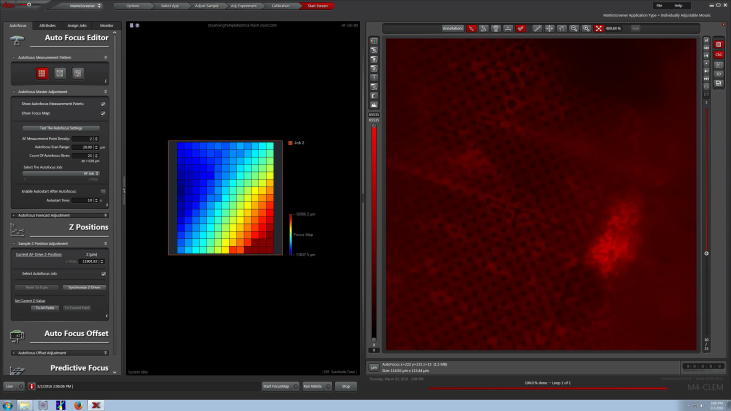
Screenshot of the MatrixScreener CLEM module. Start Screen tab, Autofocus panel. The right half of the screen shows the current image (same cells as in Fig. 3D–F). The center shows the measured and interpolated focus map with the parameters to set up the measurement on the left.